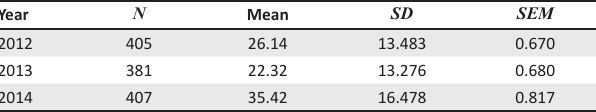
TABLE 3: Mean scores of the five schools for the three